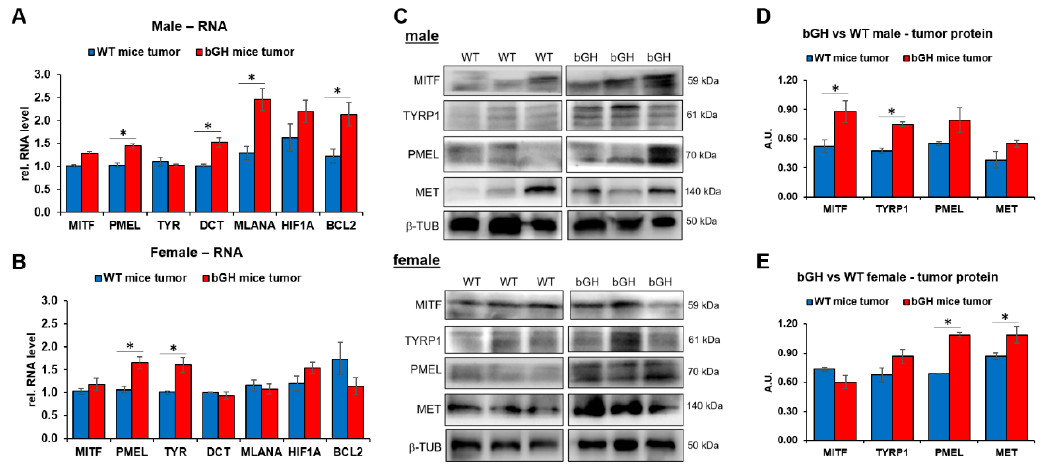
Figure 6. B16F10 mouse melanoma xenografts in bovine growth hormone transgenic (bGH) mice had elevated expression of MITF and MITF targets compared to the same in WT mice. Mouse melanoma B16F10 cells were xenografted in immunocompetent bovine growth hormone transgenic mice (bGH) as well as its wild-type littermates (WT) of both sexes ( n = 6). Tumors grown for three weeks were extracted and levels of RNA and protein were analyzed by RT-qPCR and western-blot. Excess GH in bGH mice showed upregulation of multiple target RNA and protein levels compared to WT mice. ( A , B ) Changes in RNA levels of MITF and MITF-target genes in ( A ) male and ( B ) female bGH and WT mice. ( C – E ) Changes in protein levels of MITF and MITF-targets in male ( D ) and female ( E ) bGH and WT mice as seen by western-blot ( D ) and quantified by densitometry analysis performed using ImageJ (NIH) and expression were normalized against expression of TUBB5 as loading control (*, p < 0.05, Students t test, n =